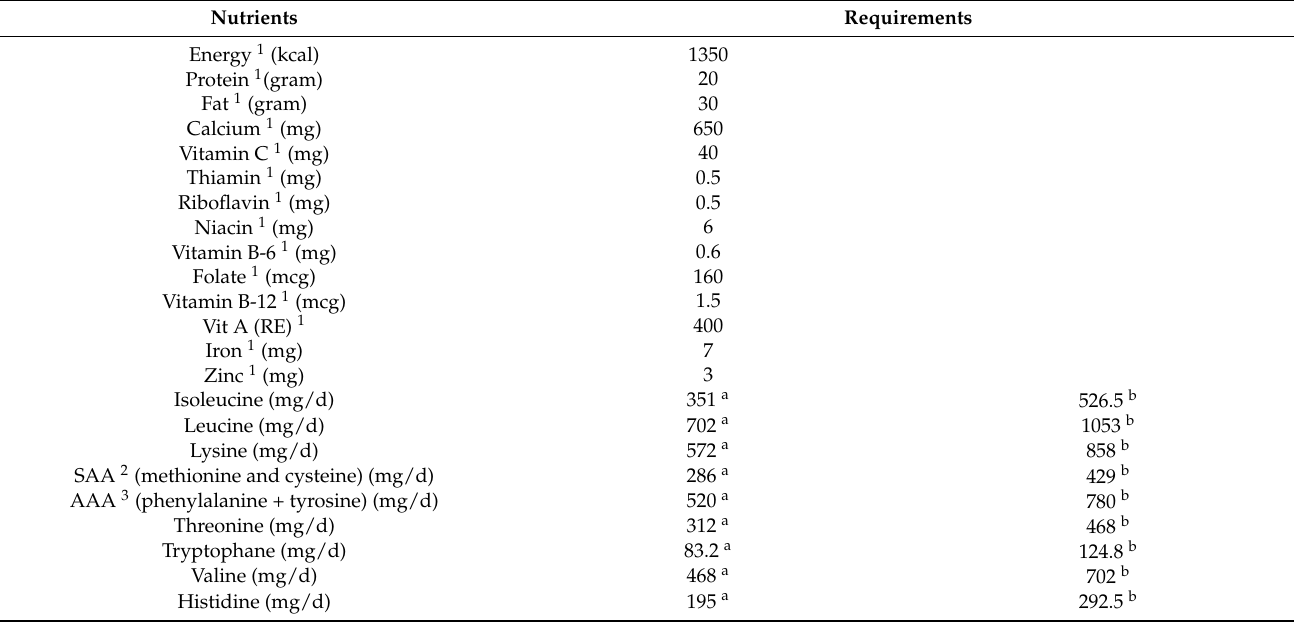
Table 1. Nutrients requirement as the target of